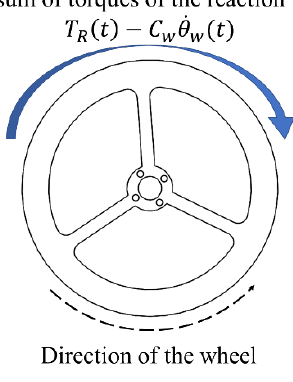
Figure 5. The torque of the reaction wheel.